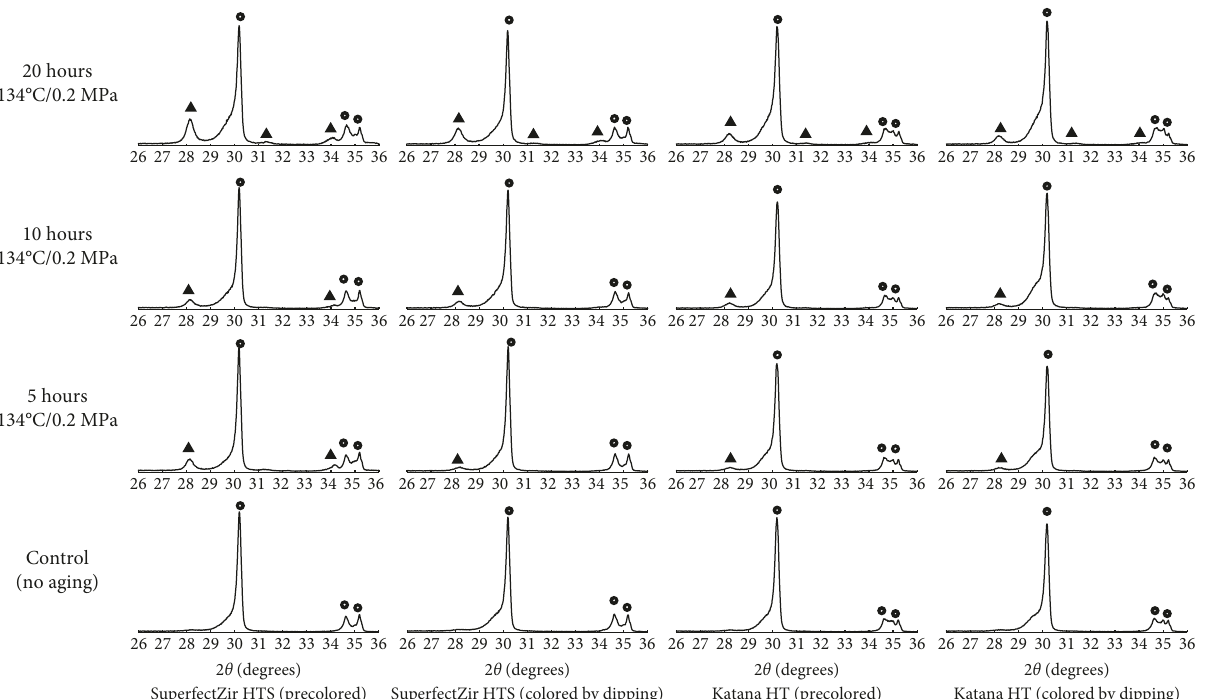
Table 4: Means and standard deviations of V